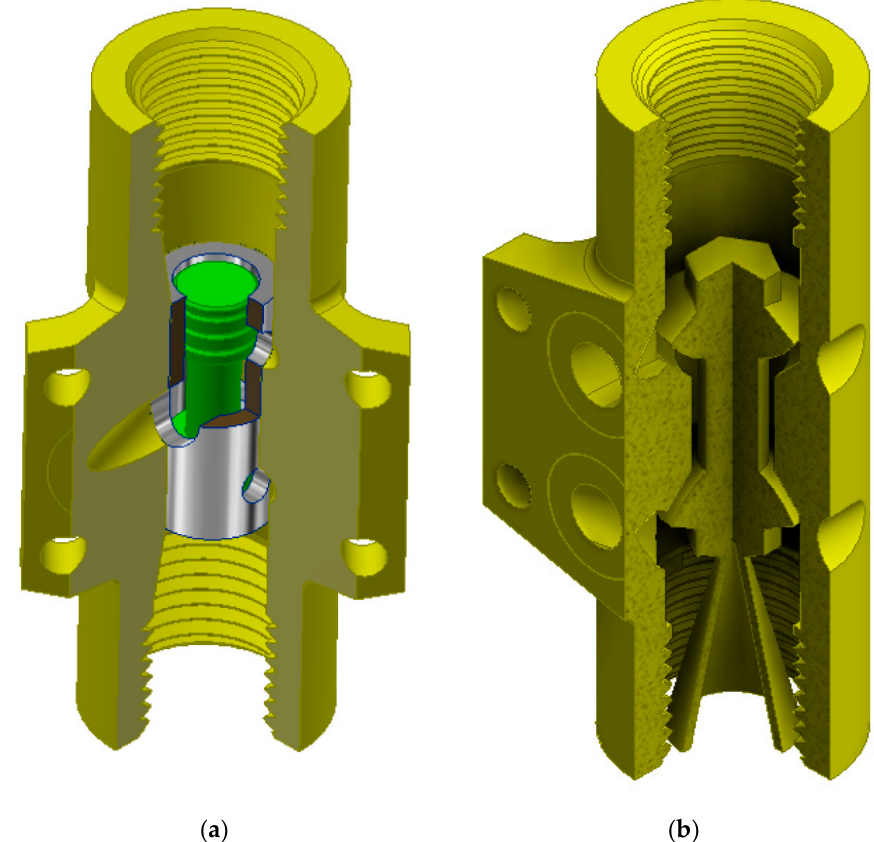
Figure 4. Cutaway view of valves: ( a ) Valve Model A, including 3D-printed PETG casing (in yellow), steel sleeve in silver, and steel spool in green. ( b ) Valve Model B, entirely 3D-printed PETG. The conical structure at the bottom is a support required during printing and is removed by gripping the hexagonal shape on the top of the spool and twisting. For both valves, pressures P A and P B are connected via passageways through the casing (not clearly visible here) to the top and bottom chambers and the charge pressure P C is connected to the center of the casing between the two hemispherical sealing surfaces. Three-dimensional-printed threads at the top and bottom accommodate pressure transducers for the prototype valve, which may be eliminated if not required. The valve designs presented here were intended to prove the concept and are not optimized (see